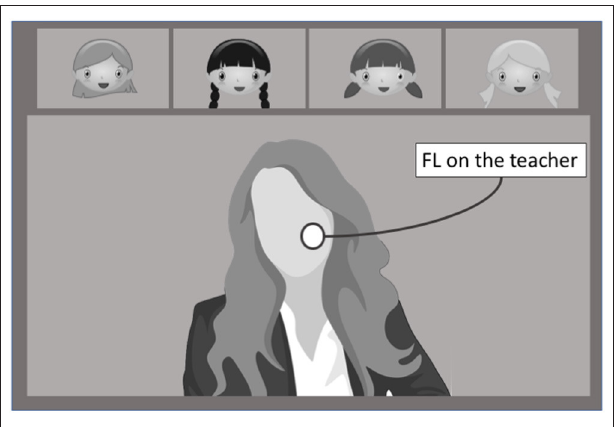
FIGURE 3 | Computation of FL on the